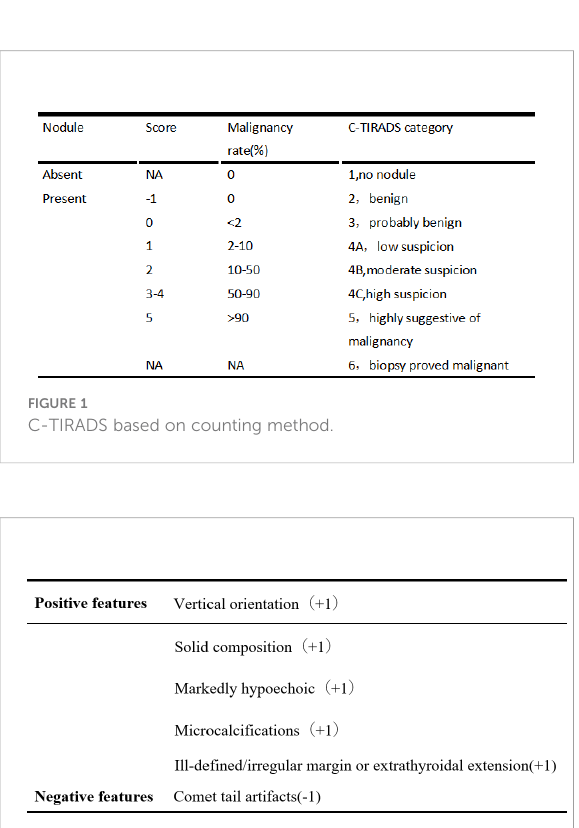
FIGURE 2 List of suspicious ultrasound features based on